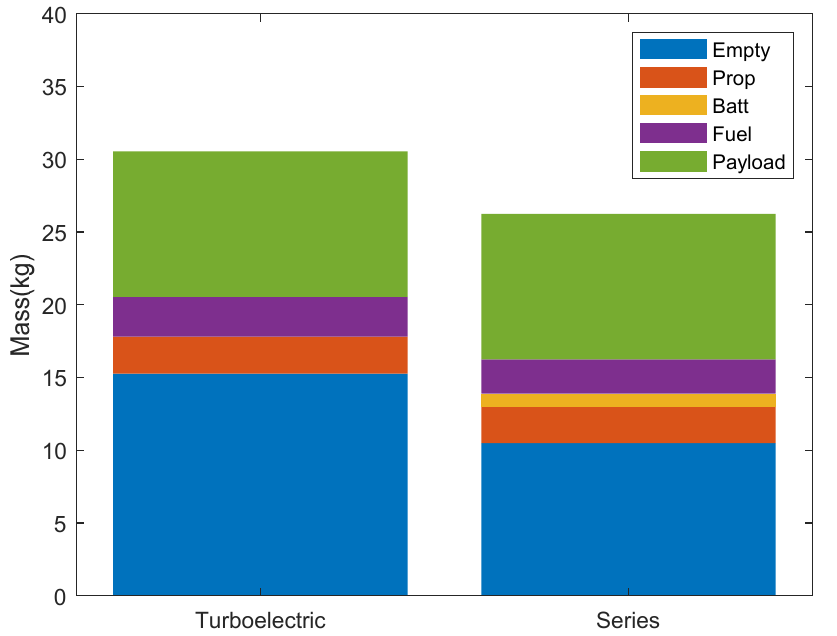
Figure 7. Case 3: MTOM and mass of other parts of UAVs. Table 5. Mission profile